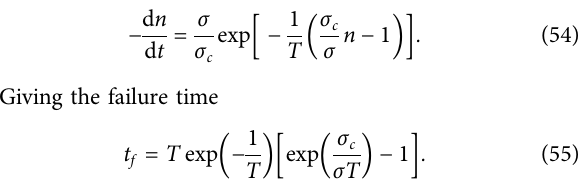
FIGURE 10 | Gamma- fi tting (dotted lines) to the waiting time distributions in California catalog (1984 –